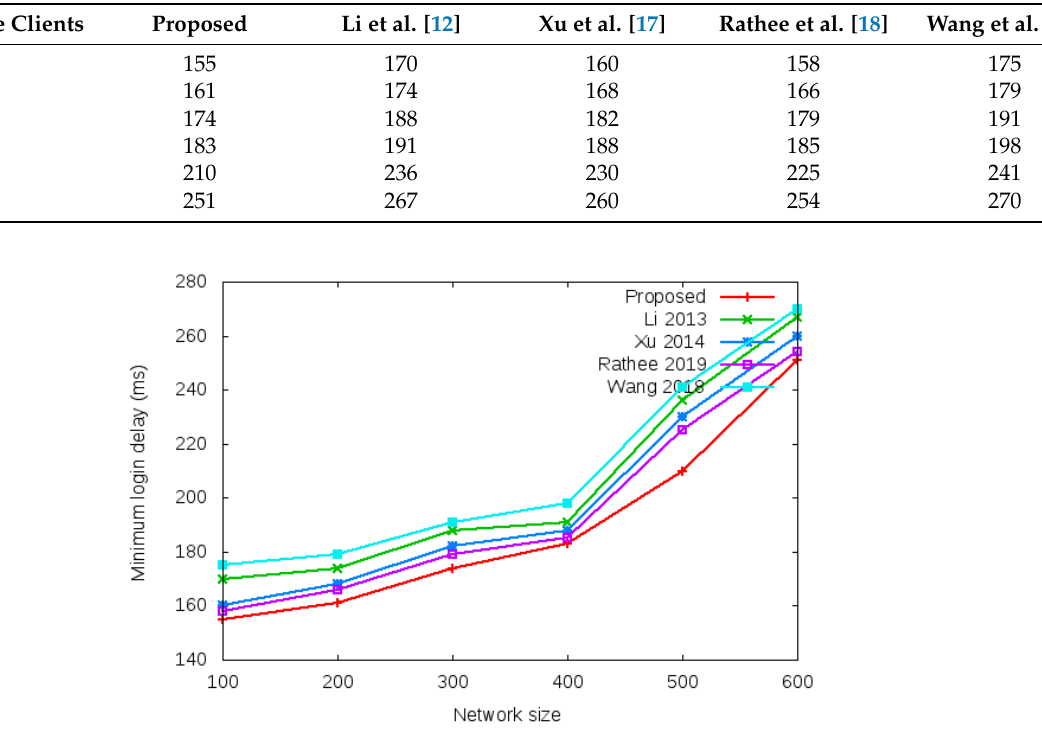
Figure 11. Minimum login authentication